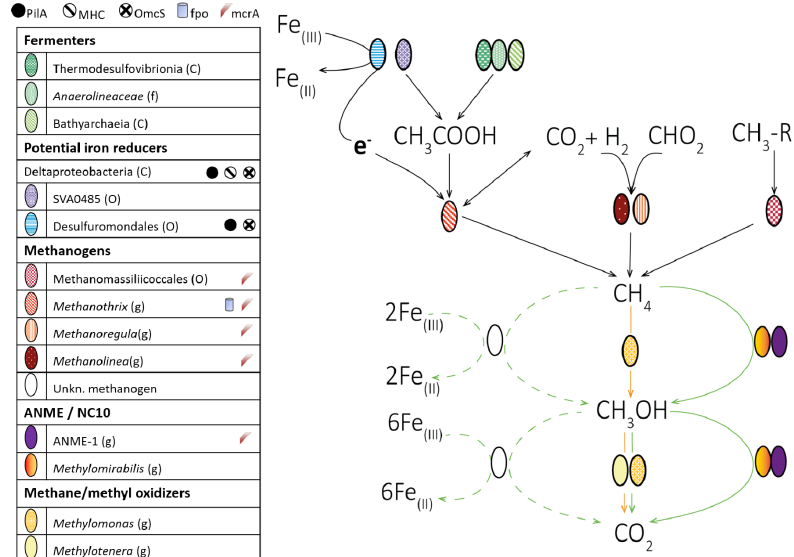
Figure 5. The reaction model of possible methane and iron cycling routes in Lake Kinneret deep sediments ( > 20cm sediment depth). Bacteria and archaea lineages are represented by ellipses. Functions associated with iron reduction (multiheme cytochromes (MHCs), PilA, OmcS, and the complex Fpo) or methanogenesis (McrA: methyl coenzyme M reductase) are represented by different symbols, and these symbols are shown next to the name of the lineages which possess them. Aerobic (orange), anaerobic (green), and unconfirmed anaerobic (dashed green) routes are displayed by arrows. These routes of methane oxidation may occur in parallel. We note that the CO 2 can be produced by back-flux reactions in methanogenesis. The highest assigned taxonomic levels are shown: class (C), order (O), family (F), and genus